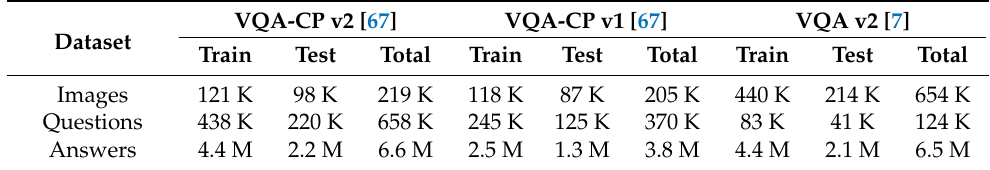
Table 1. Statistics of VQA-CP v2, VQA v2 and VQA-CP v1.